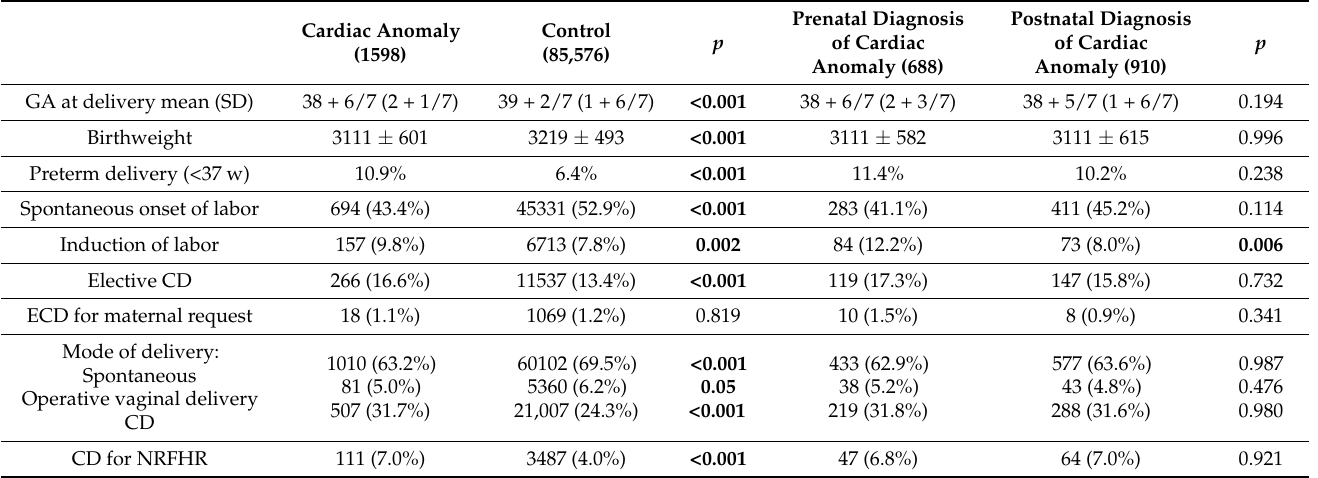
Table 2. Mode of delivery of 87,174 singleton pregnancies born after 24 0/7 weeks of gestation *-(%) of all spontaneous onset of labor.